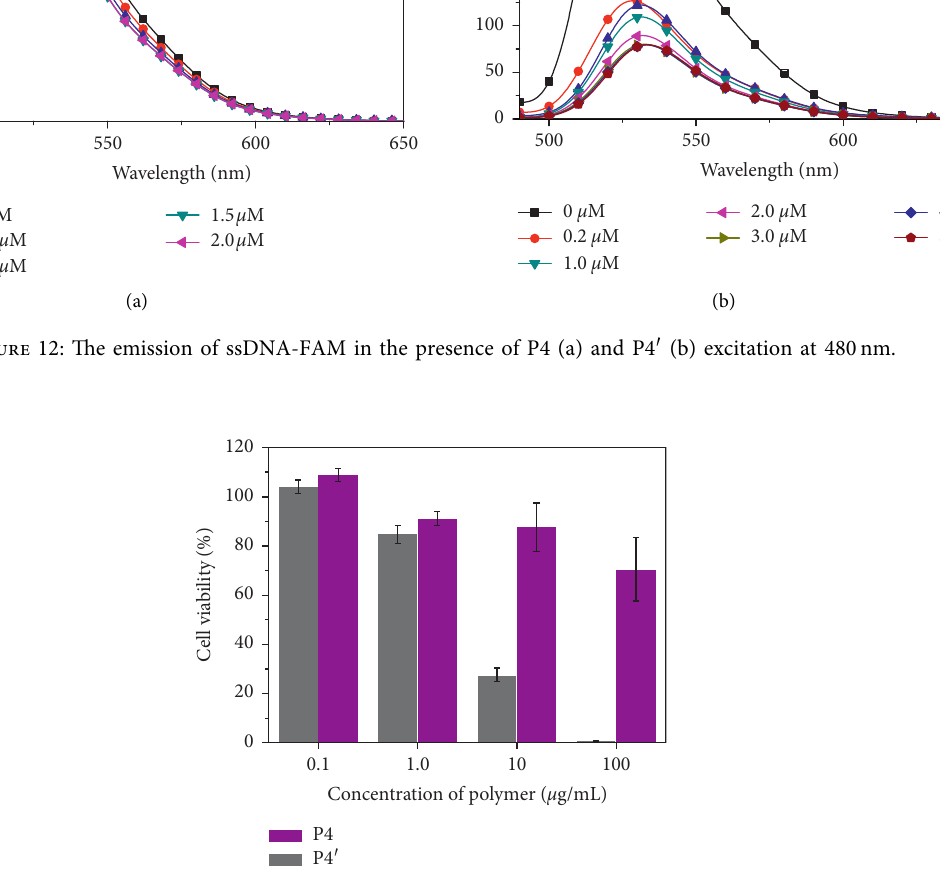
Figure 13: In vitro viability of ROW 246.7 cell exposed to P4 and P4 ′ solutions at concentrations of 0.10, 1, 10, and 100 μ g/mL for